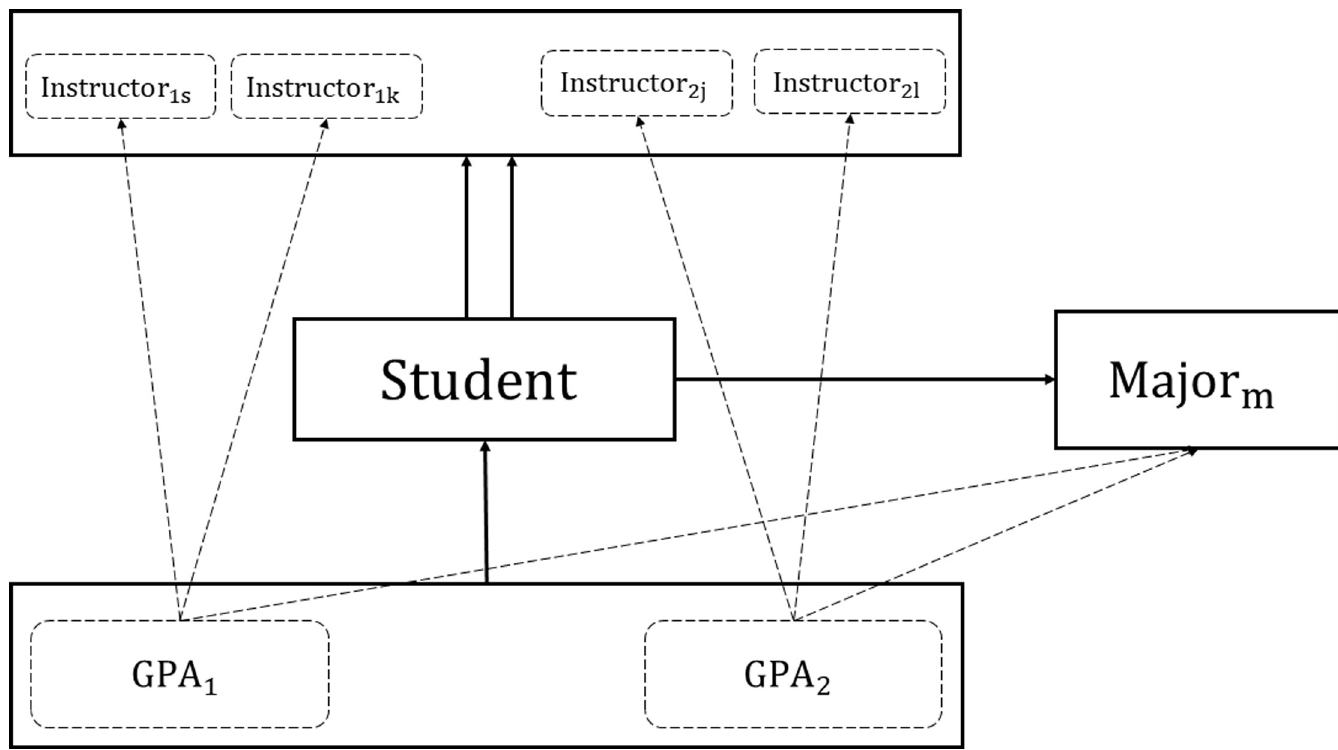
Fig 2. Data structure for students with two semesters of data, two instructors at each semester and same major in both semesters.